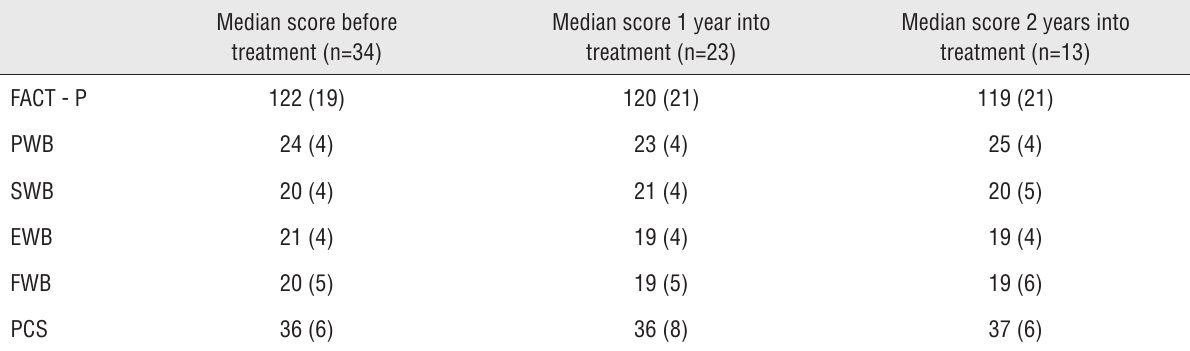
Table 8 – The average (median) FACT-P scores of patients before and after treatment. Median score before Median score 1 year treatment (n=34)